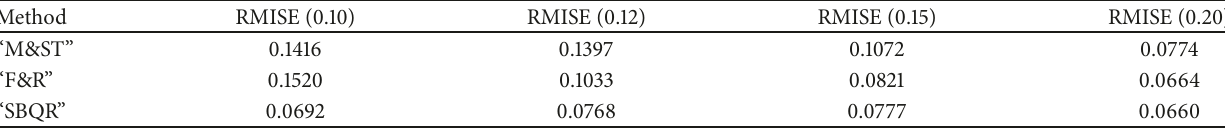
Table 4: RMISE at different quantile levels computed for M&ST, F&R, and SBQR